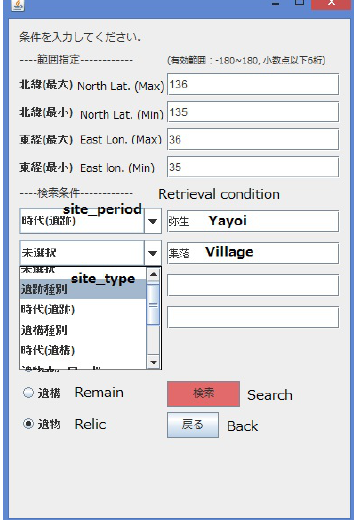
Fig. 11. Search window under the selection of an item of retrieval